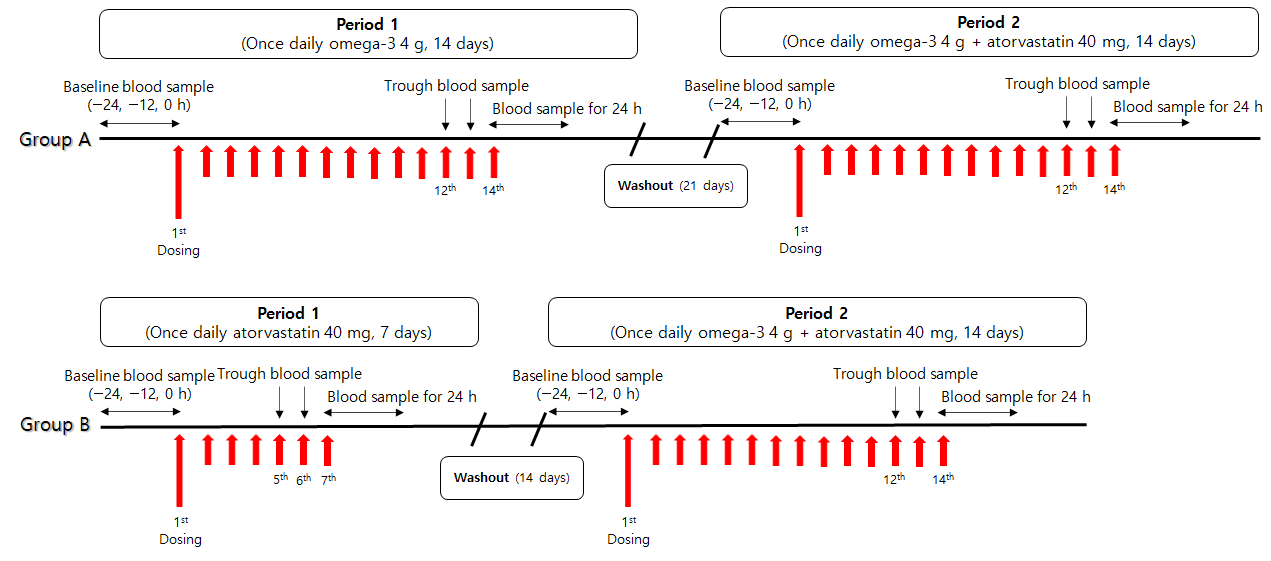
Figure 2. Study design.